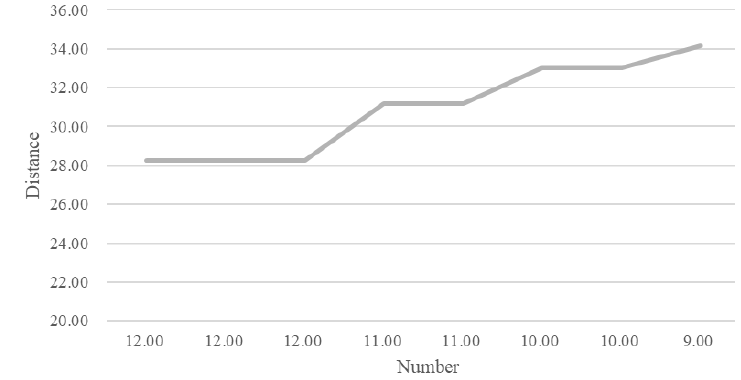
Figure 8. The second stage optimal Pareto solution. Table 20. Deviations in different solutions in the second stage.